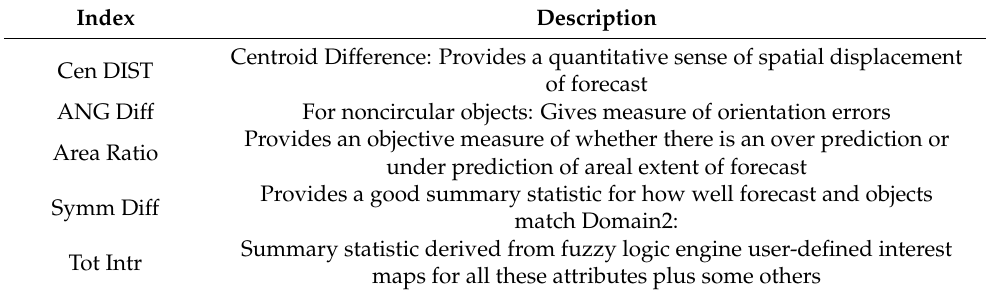
Table 5. Description of MODE indices used for analysis (https://met.readthedocs.io/en/main_v9.1 /Users_Guide, accessed on 3 March